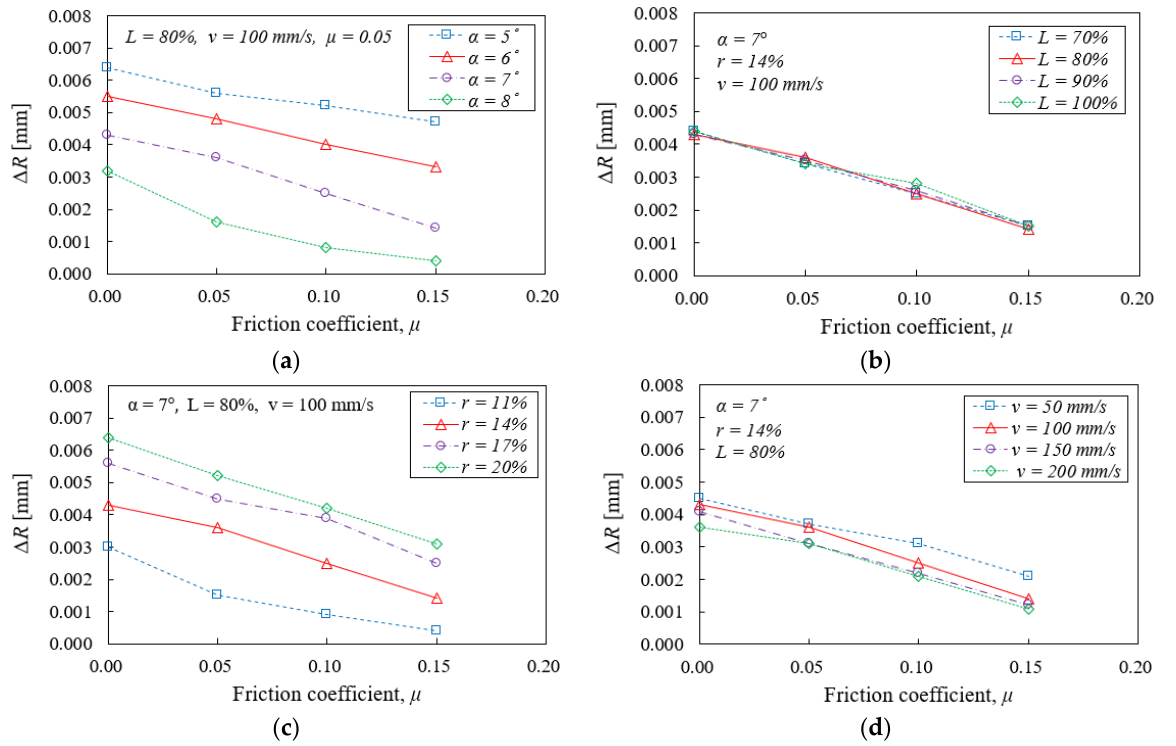
Figure 10. Effects of friction coefficient on ∆ R under different conditions. ( a ) Different semi-die angles; ( b ) different bearing ratios; ( c ) different reduction ratios; ( d ) different drawing speeds.